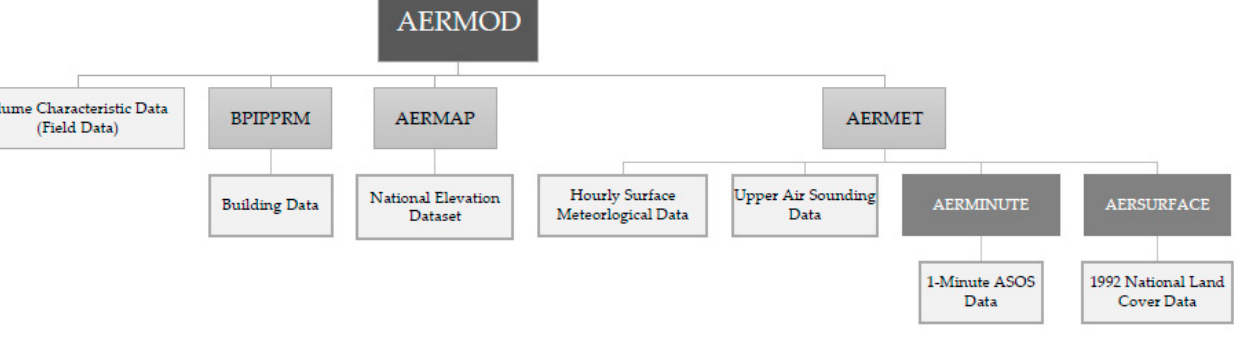
Figure 2. AERMOD System and